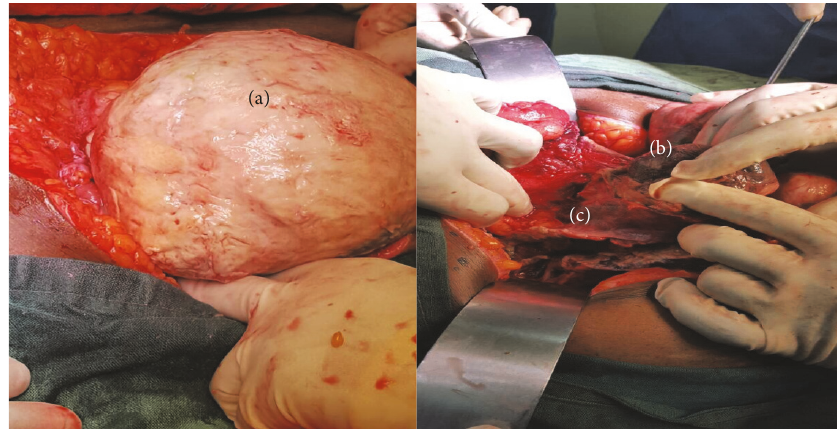
Figure 1: Necrosed uterus (a) and matted Necrosed Myomas (b). Serosal adhesions to small and large bowel